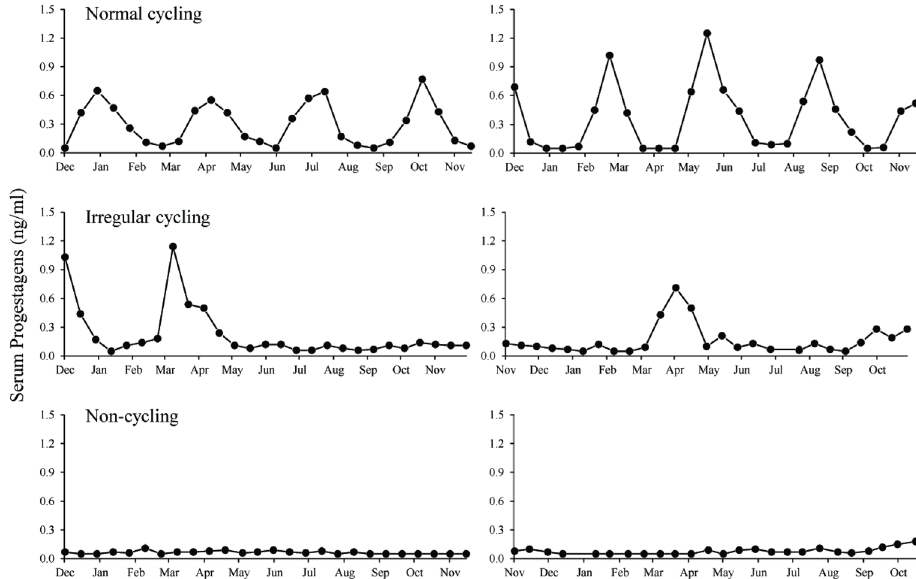
Fig 1. Representative serum progestogen profiles for normal cycling (upper panels), irregular cycling (middle panels) and acyclic (lower panels) female African elephants blood sampled